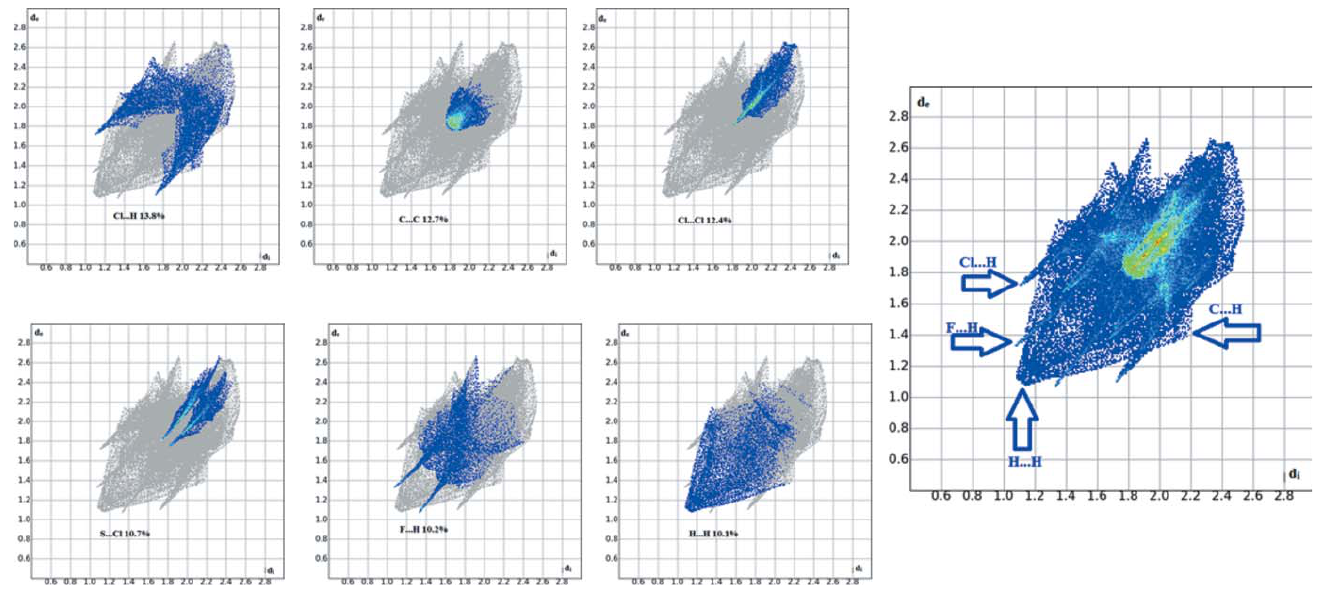
Figure 5 Two-dimensional fingerprint plots showing the percentage contributions of the various interactions.